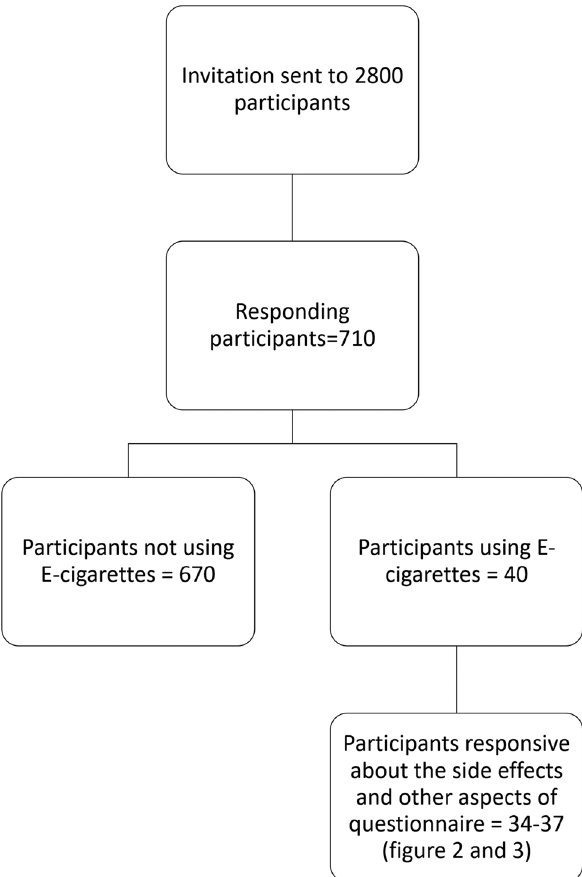
Figure 1: The consort diagram of study